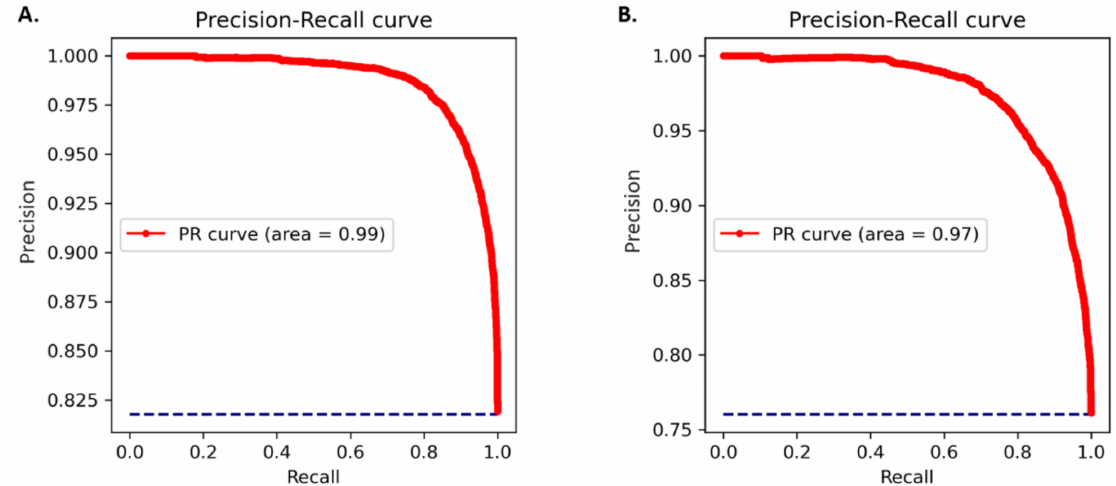
Figure 1. AUROC curves for the ( A ) protein model and ( B ) nucleotide model. The true positive rate is plotted against false positive rate at different classification thresholds.